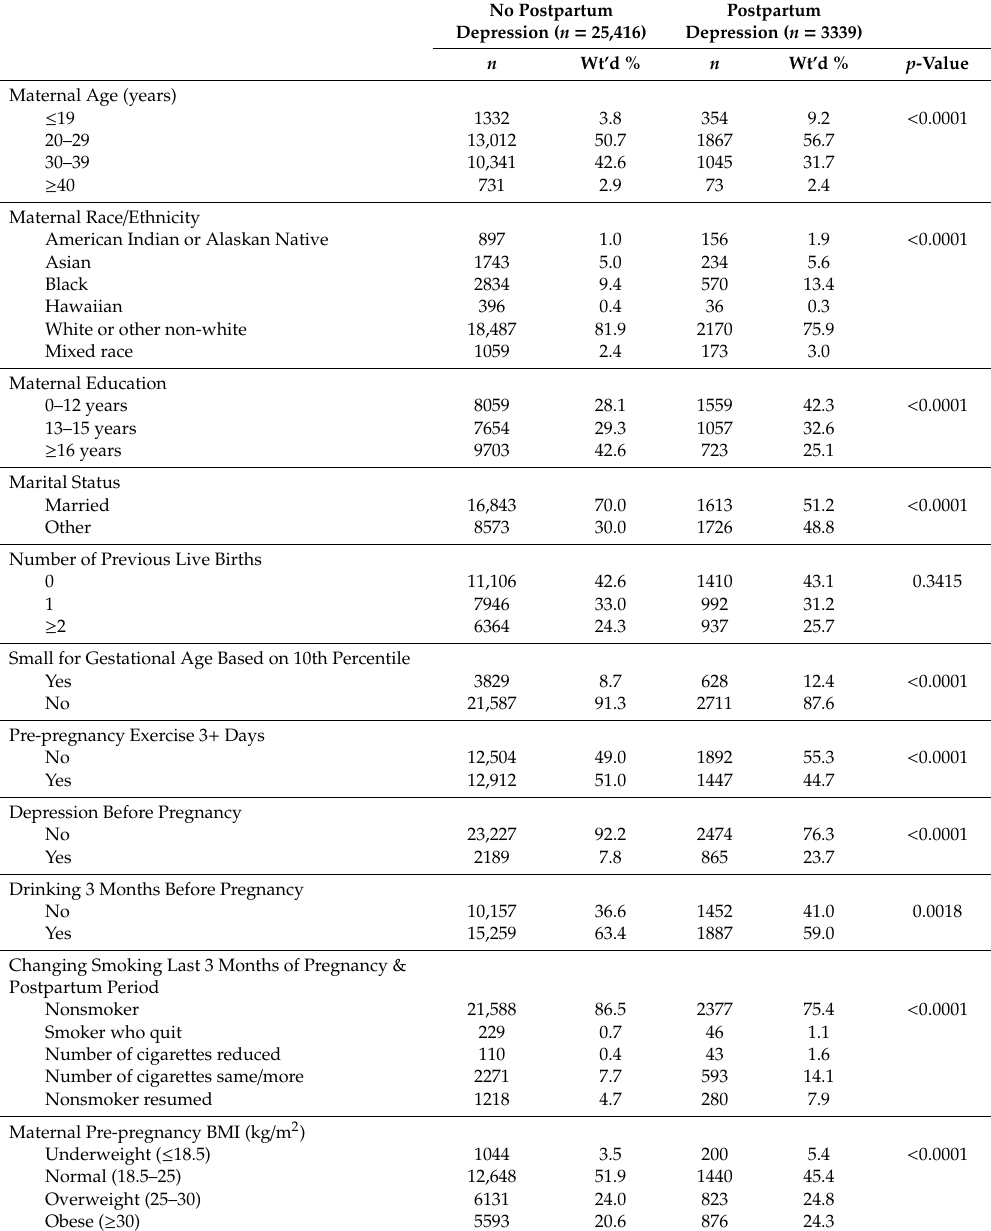
Table 1. Maternal demographic by the status of postpartum